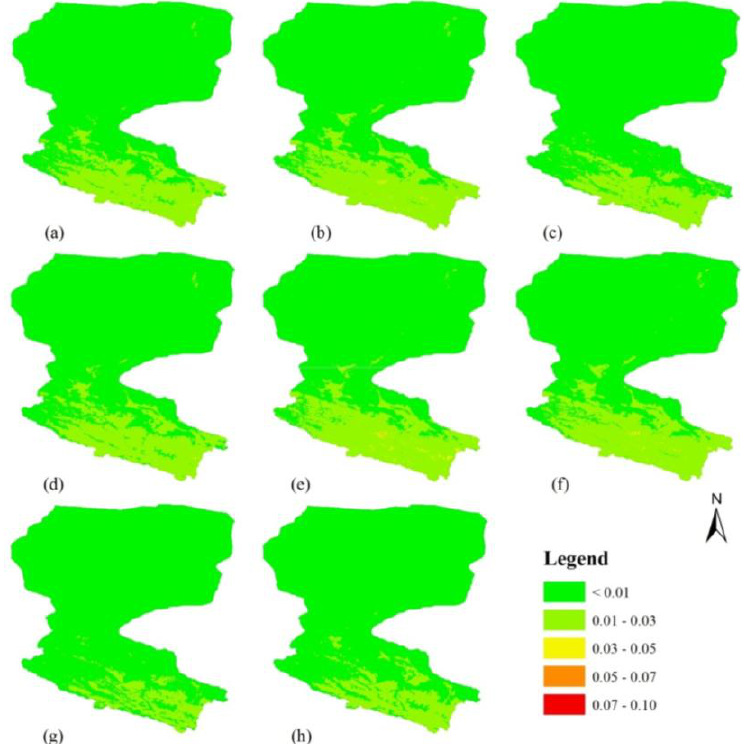
Figure 8. Root mean square error (RMSE) of the SPOT NDVI data for the eight techniques: ( a ) the asymmetric Gaussian (A-G) technique, ( b ) the modified-best index slope extraction (M-BISE) technique, ( c ) the changing-weight filter (CW) technique, ( d ) the double logistic function (D-L) technique, ( e ) the iterative interpolation for data reconstruction (IDR) technique, ( f ) the mean value iteration (MVI), ( g ) the Savitzky-Golay filter (S-G) technique, and ( h ) the Whittaker smoother (WS) technique.